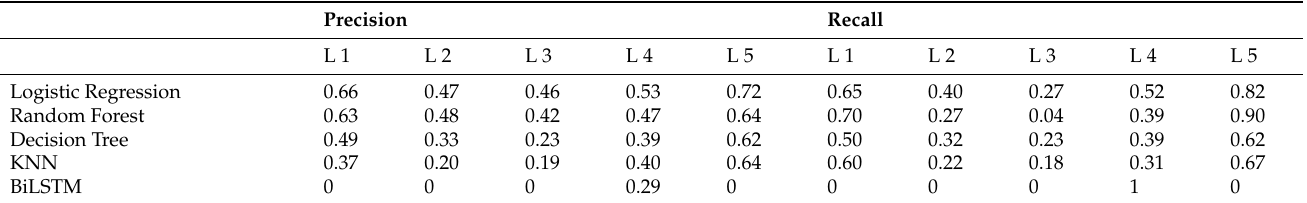
Table 3. Precision and recall for scenario 4 with the classification method (Y = “Rating”).